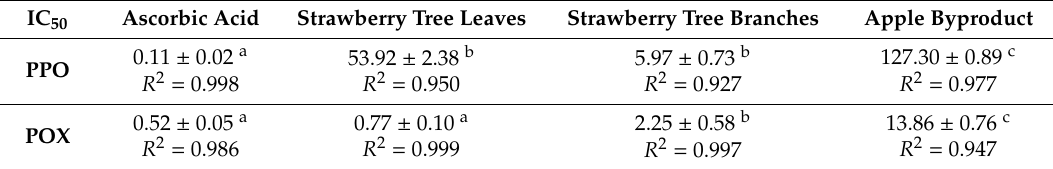
Table 5. Values of IC 50 of NES. Ascorbic acid was used as positive control for PPO (polyphenoloxidase) and POX (peroxidase)